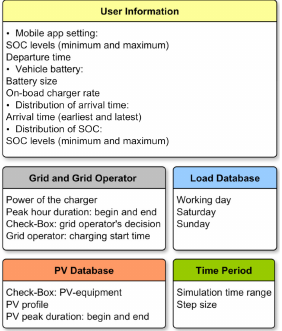
Figure 2. Structure of data collection in the V2G